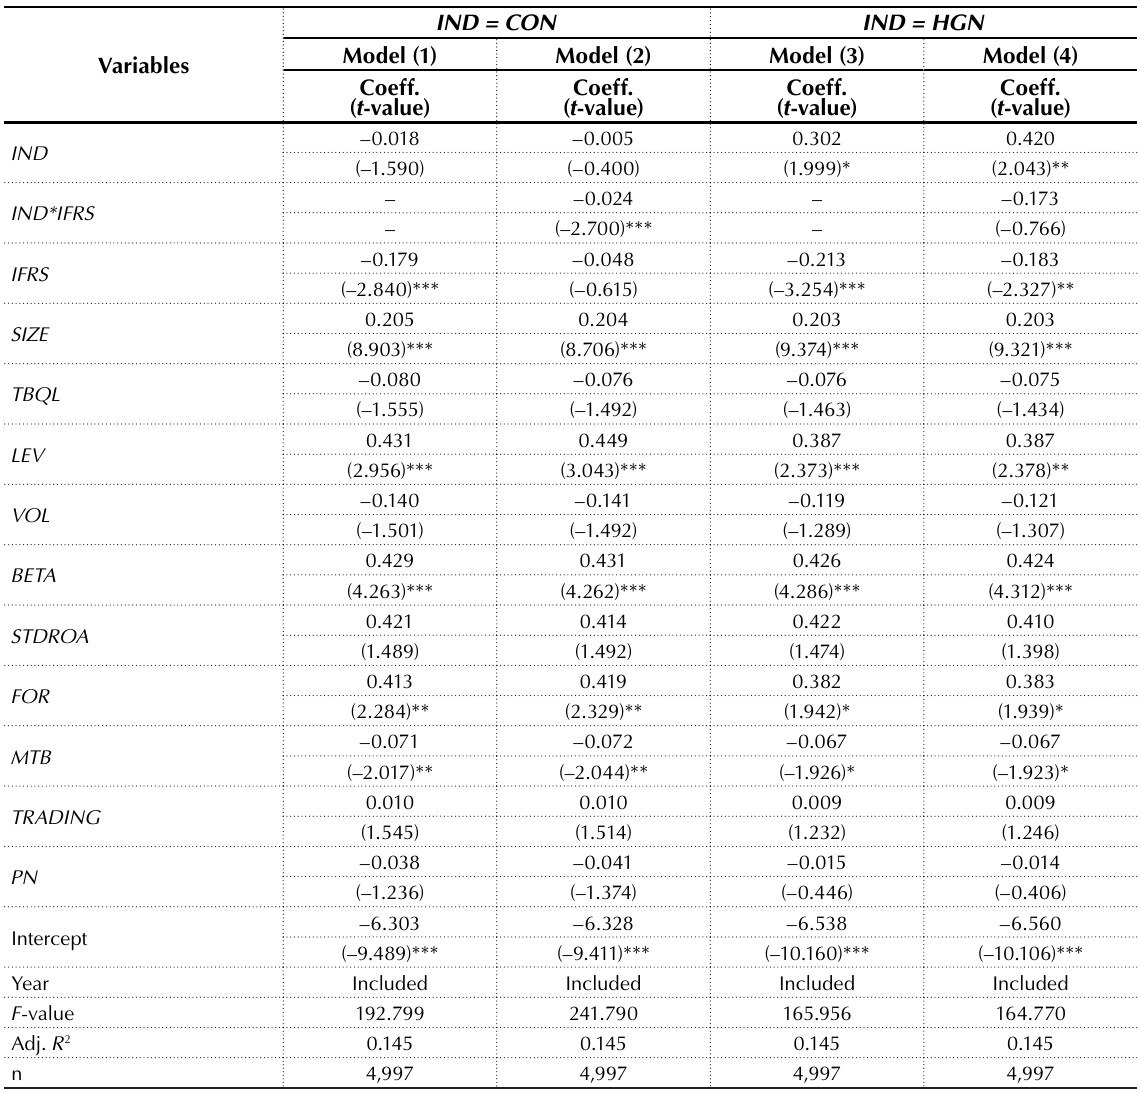
Table 3. Test results for